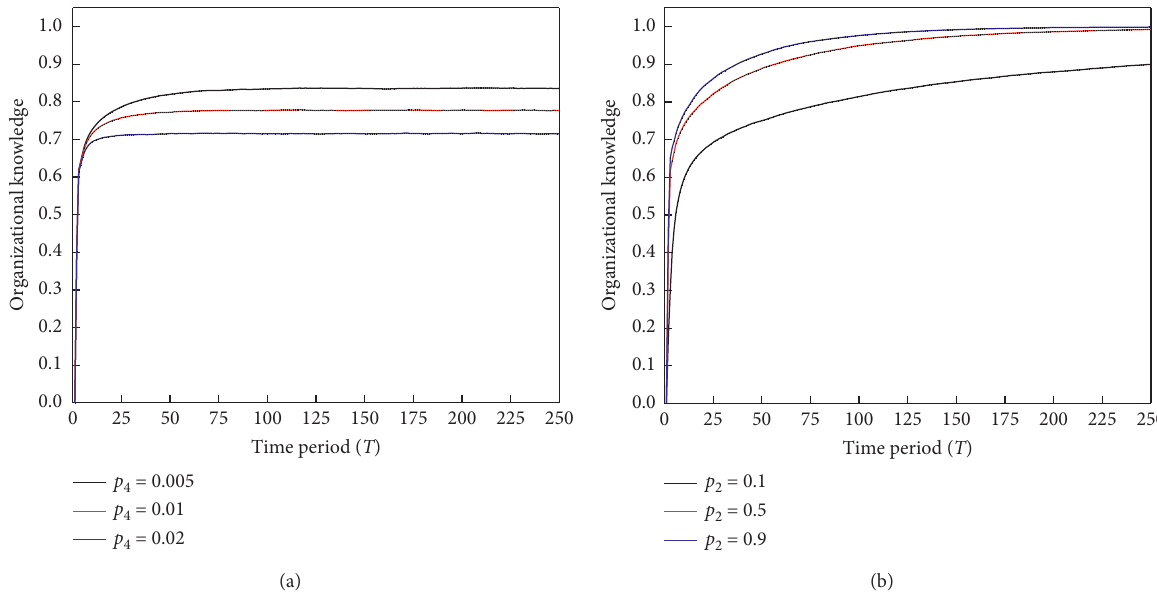
Figure 8: Effect of practice time on organizational knowledge. (a) Environmental dynamism ( p absorptive capacity ( p 1 � 0.5, p 3 � 0.5, p 4 �